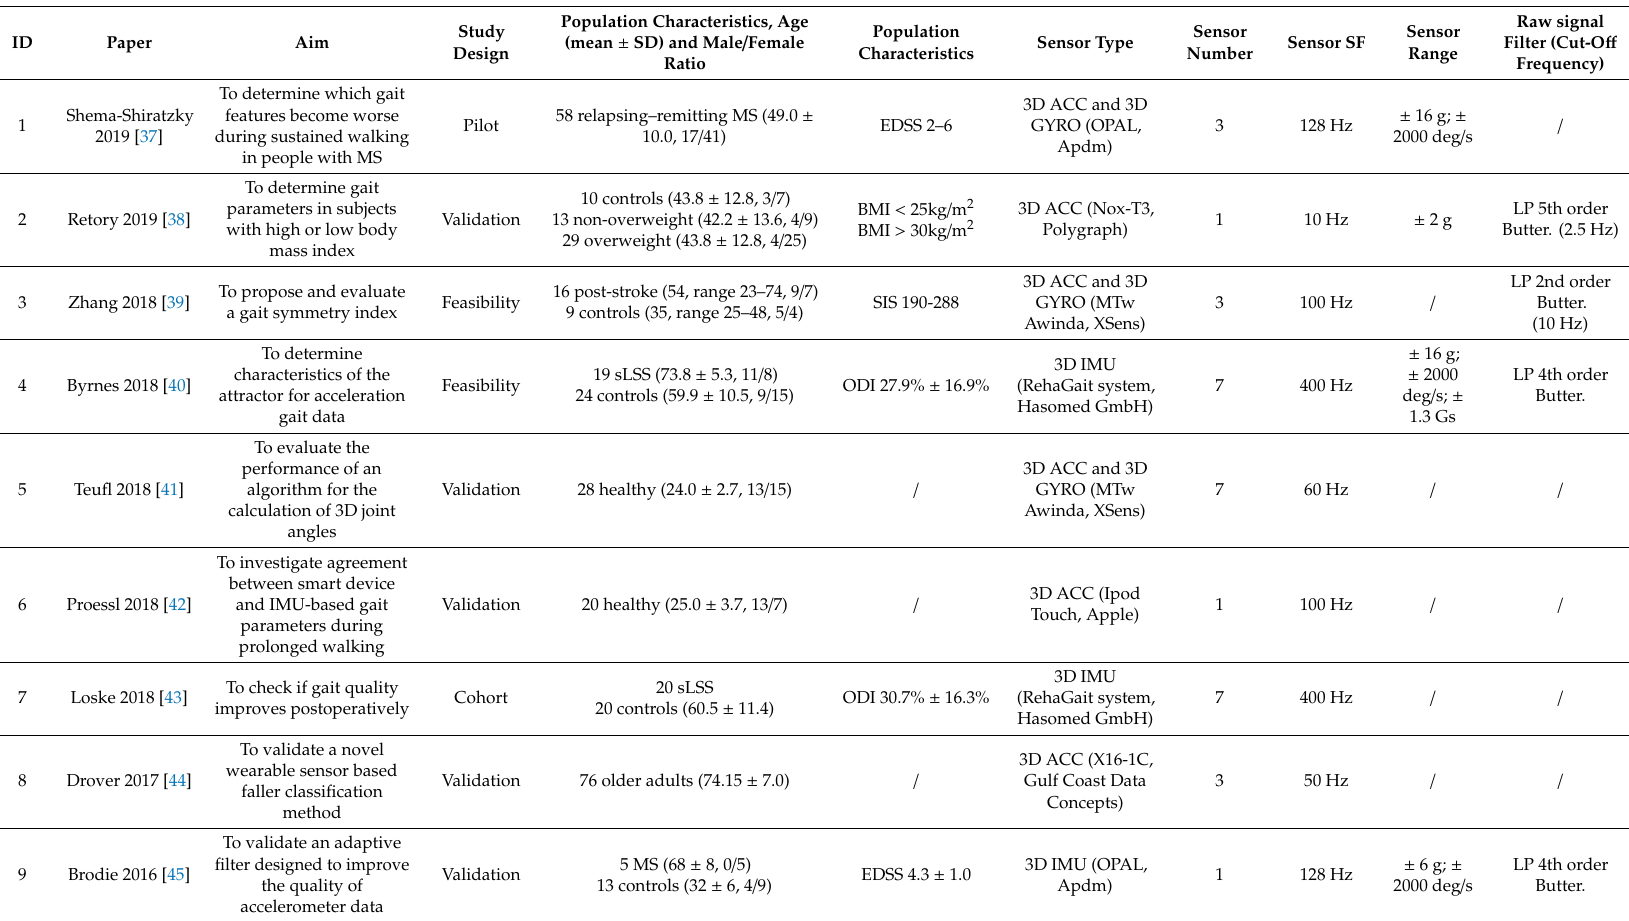
Table 2. Summary of the main characteristics of the articles included in the